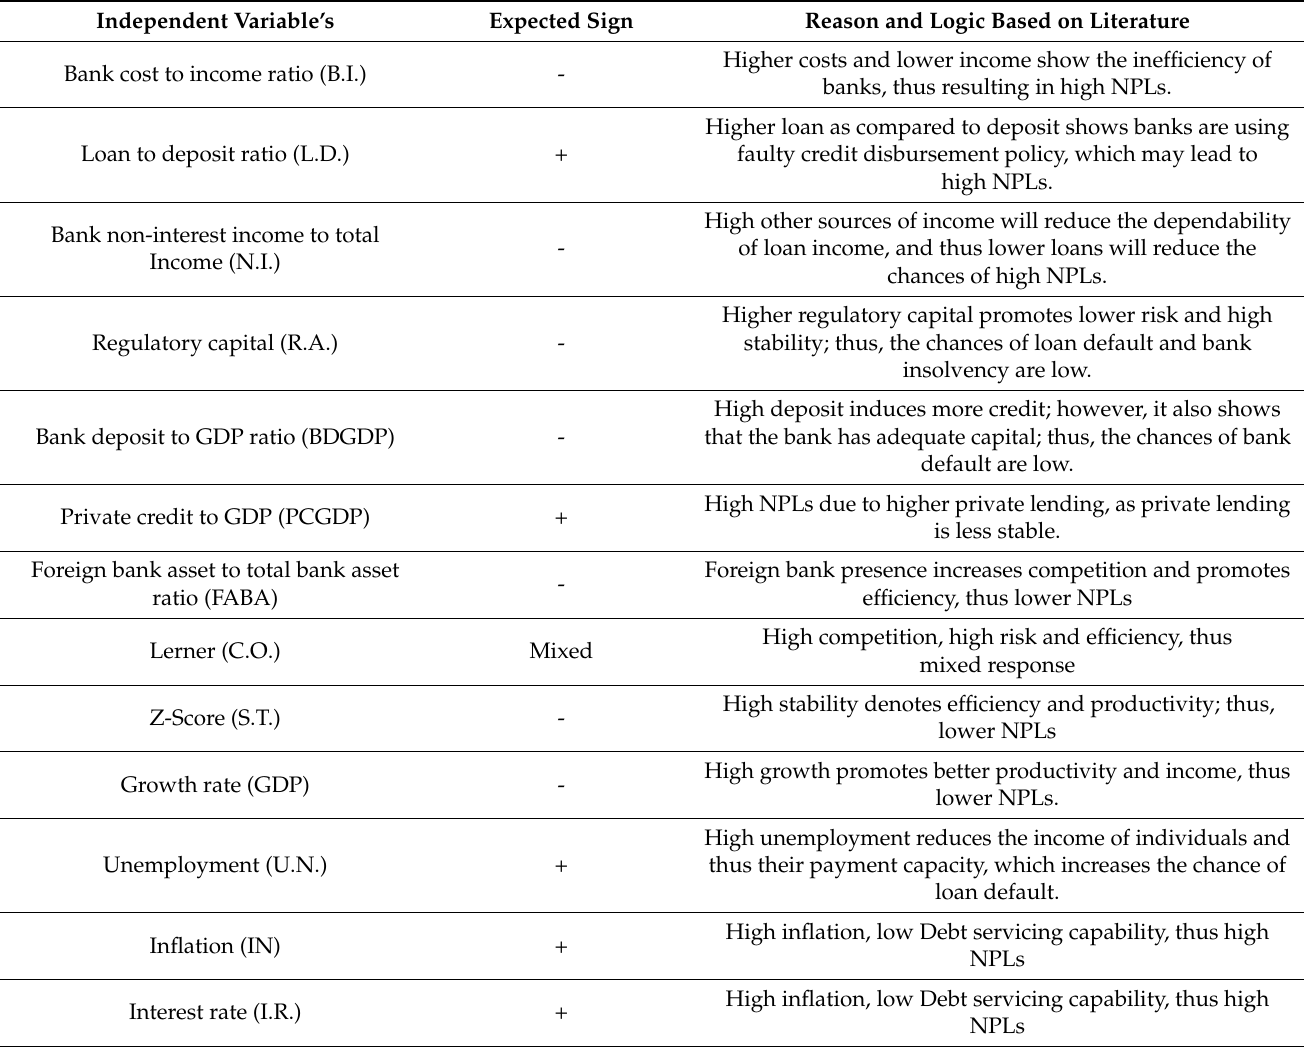
Table 1. Expected relationship, logic, and reason for selecting variables and detail of Emerging